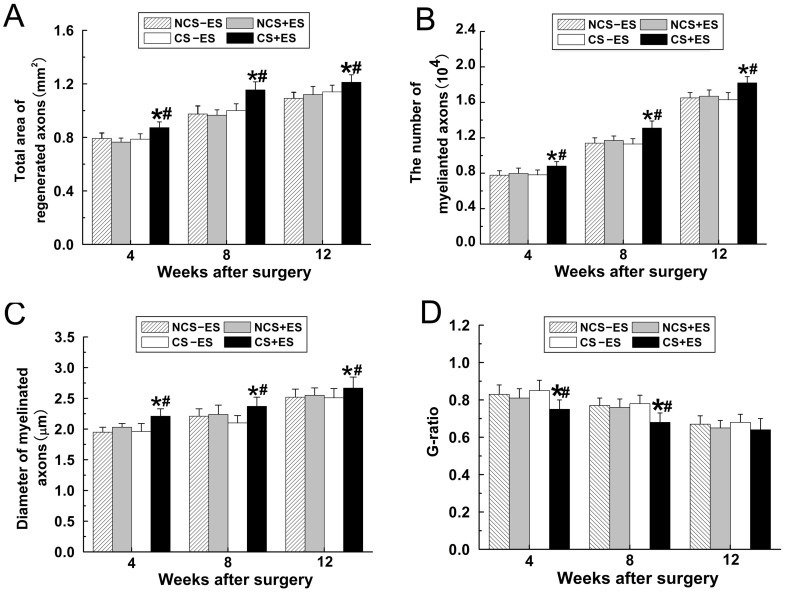
Morphometric analysis of axonal regeneration and remyelination were performed in the CS+ES group, CS−ES group, NCS+ES group and NCS−ES group at the predefined time points.The parameters reflecting axonal regeneration and remyelination includes the cross section area of regenerated nerve (A), quantification of the myelinated axons (B), the diameter of myelinated axon (C), and G-ratio (D) at 4 w, 8 w and 12 w following surgery. All data were expressed as the mean ±standard deviation. *p<0.05 for the comparison with CS−ES group. #
p<0.05 for the comparison with NCS+ES group.